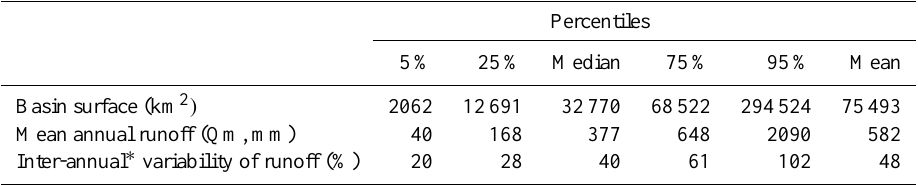
Table 2. Statistics for the 42 gauging stations of river discharge used in the model evaluation.